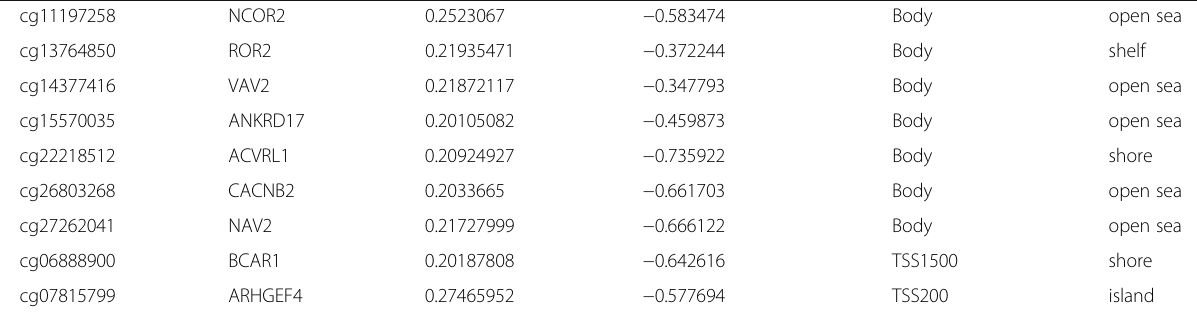
Table 1 Correlation between DNA methylation (Probe ID) and gene expression (Gene) in hypoxia (Continued)